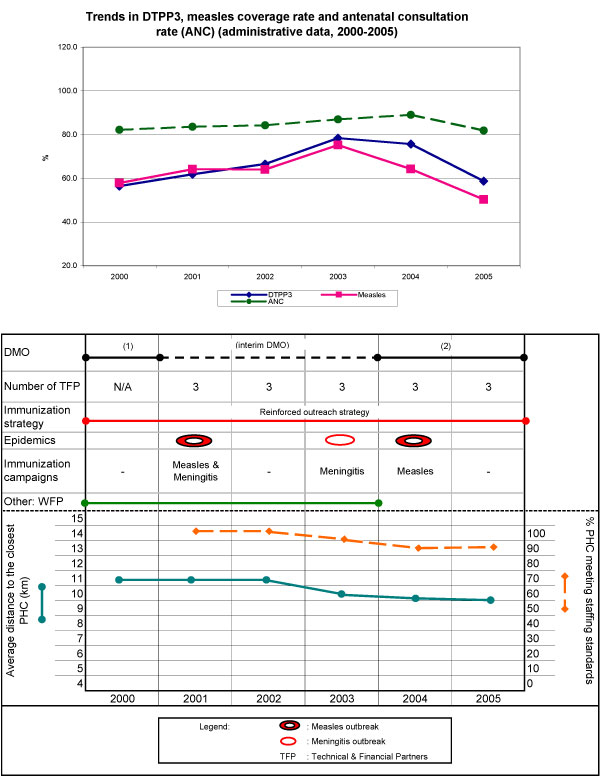
Health district of Dié.